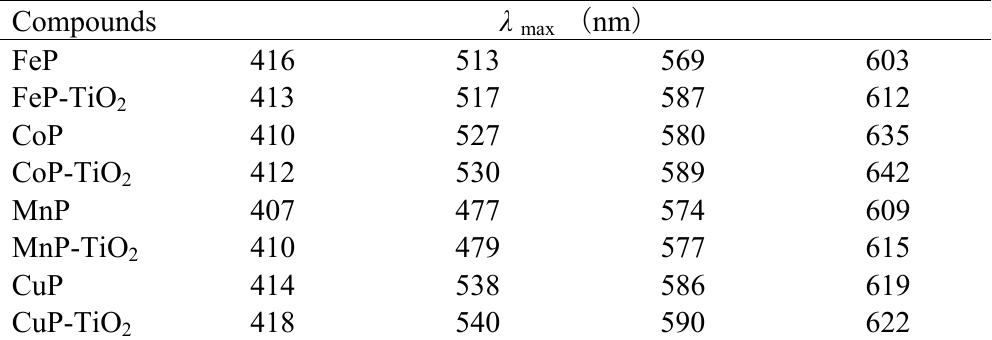
Table 1. UV-vis data of metalloporphyrins and DR data of